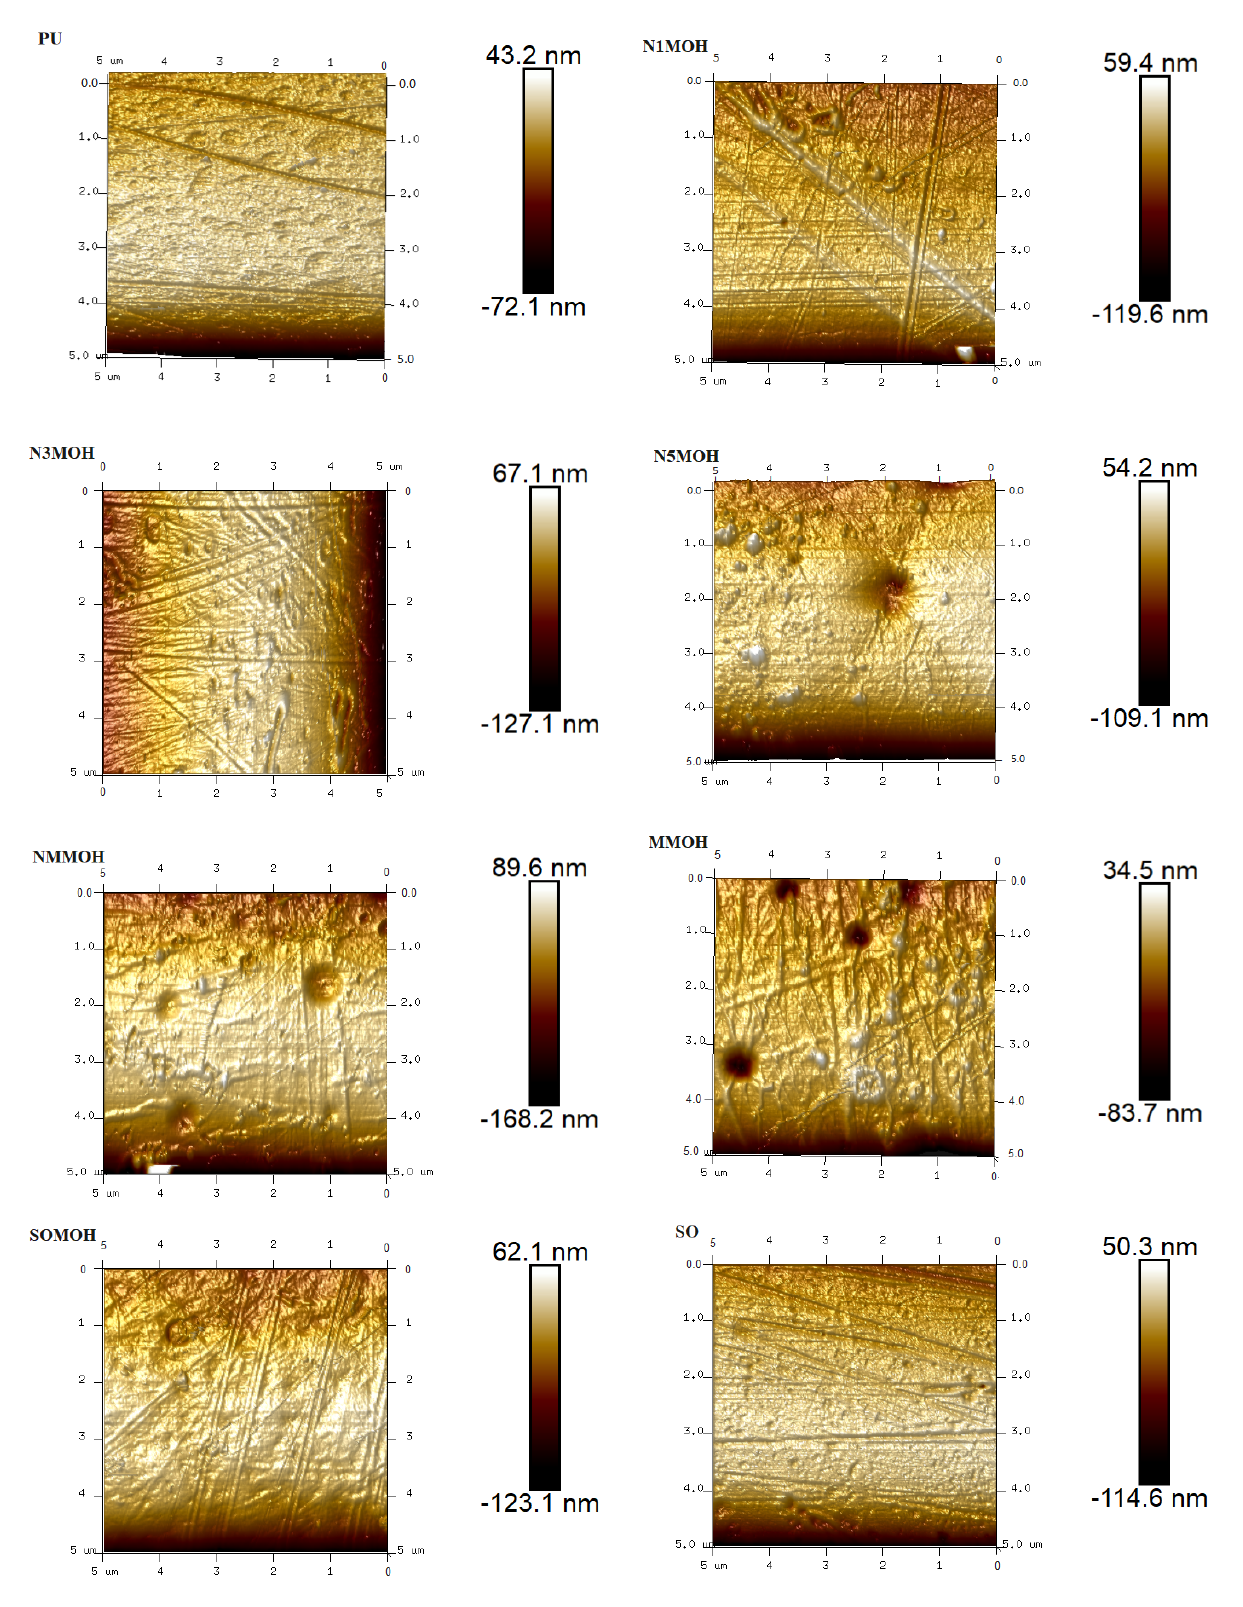
Figure 7. AFM analysis and the surface roughness changes in the PU composite samples produced via the addition of nano- and